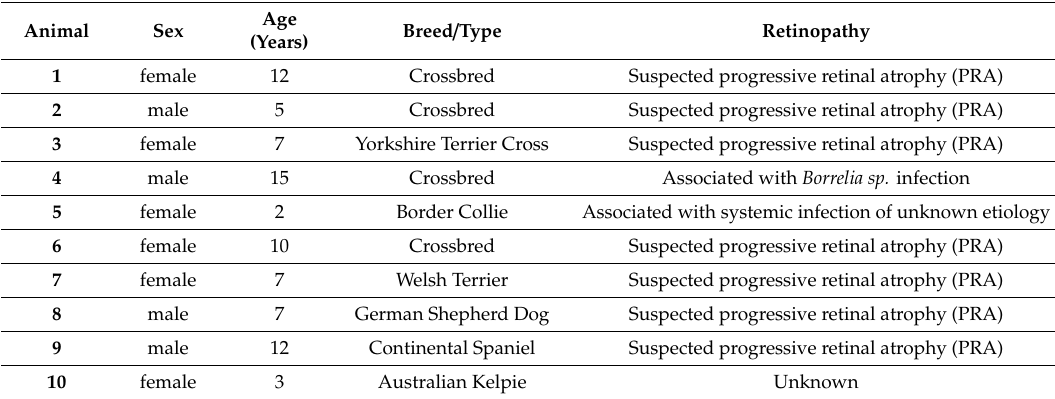
Table 1. Characteristics of animals used in the